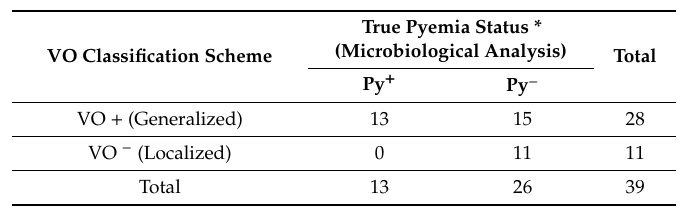
Table 6. Association between VO classification scheme results and true pyemia status of 39 finishing pigs detected with vertebral osteomyelitis during ordinary meat inspection in one Portuguese abattoir in the winter of